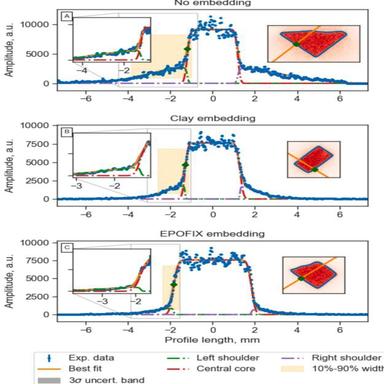
Comparison of typical intensity profiles for different embedding materials: (A) no embedding, (B) modelling clay, and (C) EPOFIX. The experimental data (blue points) are shown along with the result of the best fit (orange line) and its three components (dot-dashed lines). The yellow shaded area represents the intensity range from 10% to 90% of the maximum intensity. The right insets display the image from which the profile is extracted, with the blue contour line indicating the 50% level, the orange line re